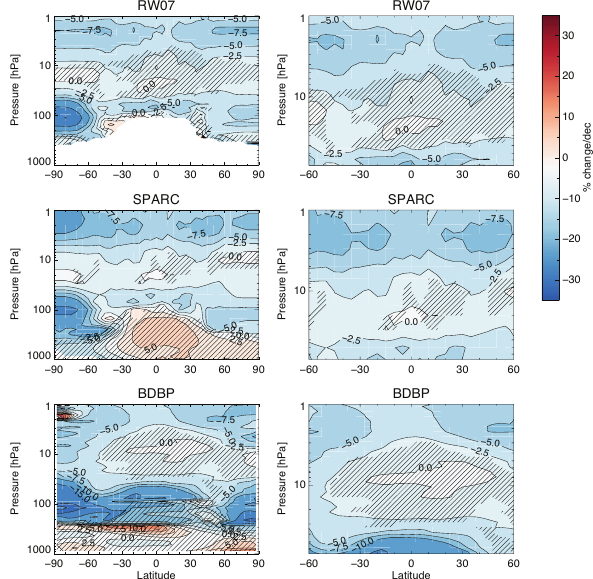
Figure 8. Left column: Annual mean trend [% per decade] as a function of latitude and pressure for the time period 1979 to 1996, for the RW07 dataset, for the SPARC dataset, and the BDBP dataset. Hatched regions show trends that are not significantly different from zero at the 2 ! level. Blue colours indicate negative trends, red colours indicate positive trends. Contour levels are: ±35, ±30, ±25, ±20, ±15, ±10, ±7.5, ±5, ±2.5, 0. Right column: same as left column, but enlarged to the region 60°S to 60°N, 70 hPa to 1 hPa. Note that no trend values are available for RW07 in the troposphere since RW07 is only defined in the stratosphere.